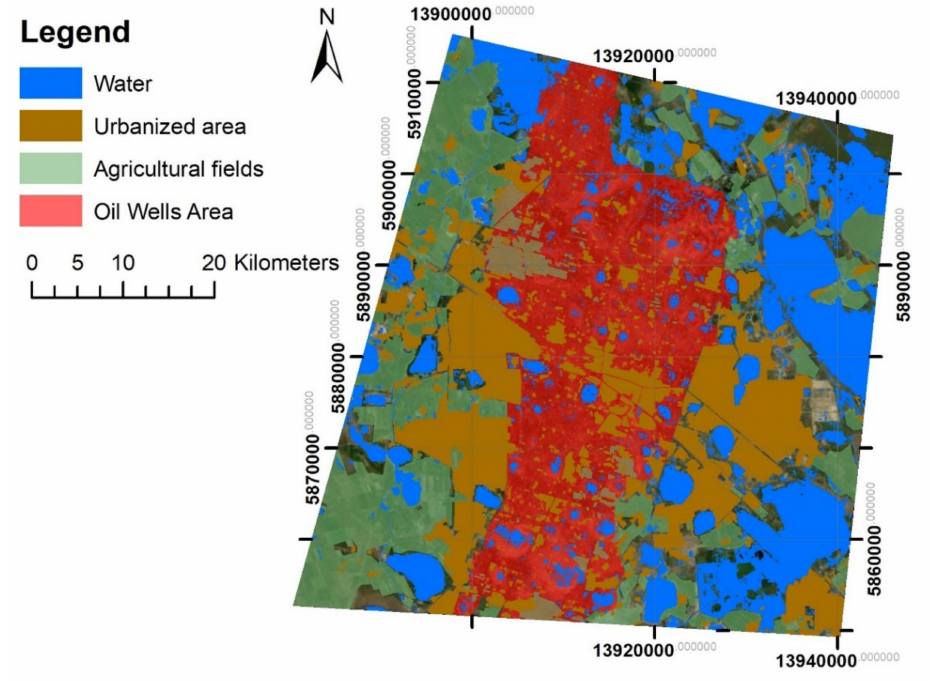
Figure 6. Result of the mapping of Daqing area with the different layers. Map by S. J. Hauser with the software